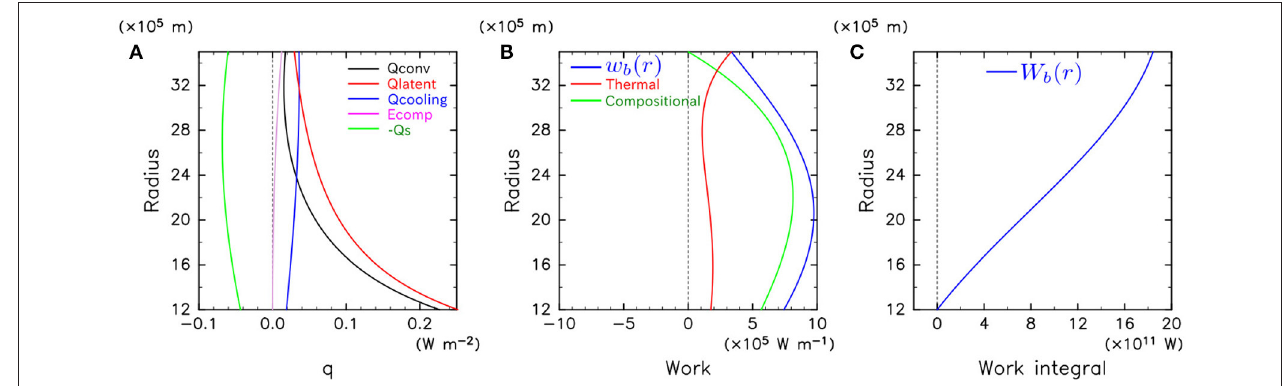
FIGURE 2 | Result of 1-dimensional thermal and compositional budget model for Q CMB = 12TW. (A) Radial distributions of heat flows. Black, blue, purple, red and green lines indicate Q conv , Q cooling , E comp , Q latent , and Q s , respectively. (B) Radial distributions of work by buoyancy forces w b ( r ). Green and red lines indicate contributions from compositional and thermal buoyancies. Blue line shows total work. (C) Radially integrated work by buoyancy forces W b ( r